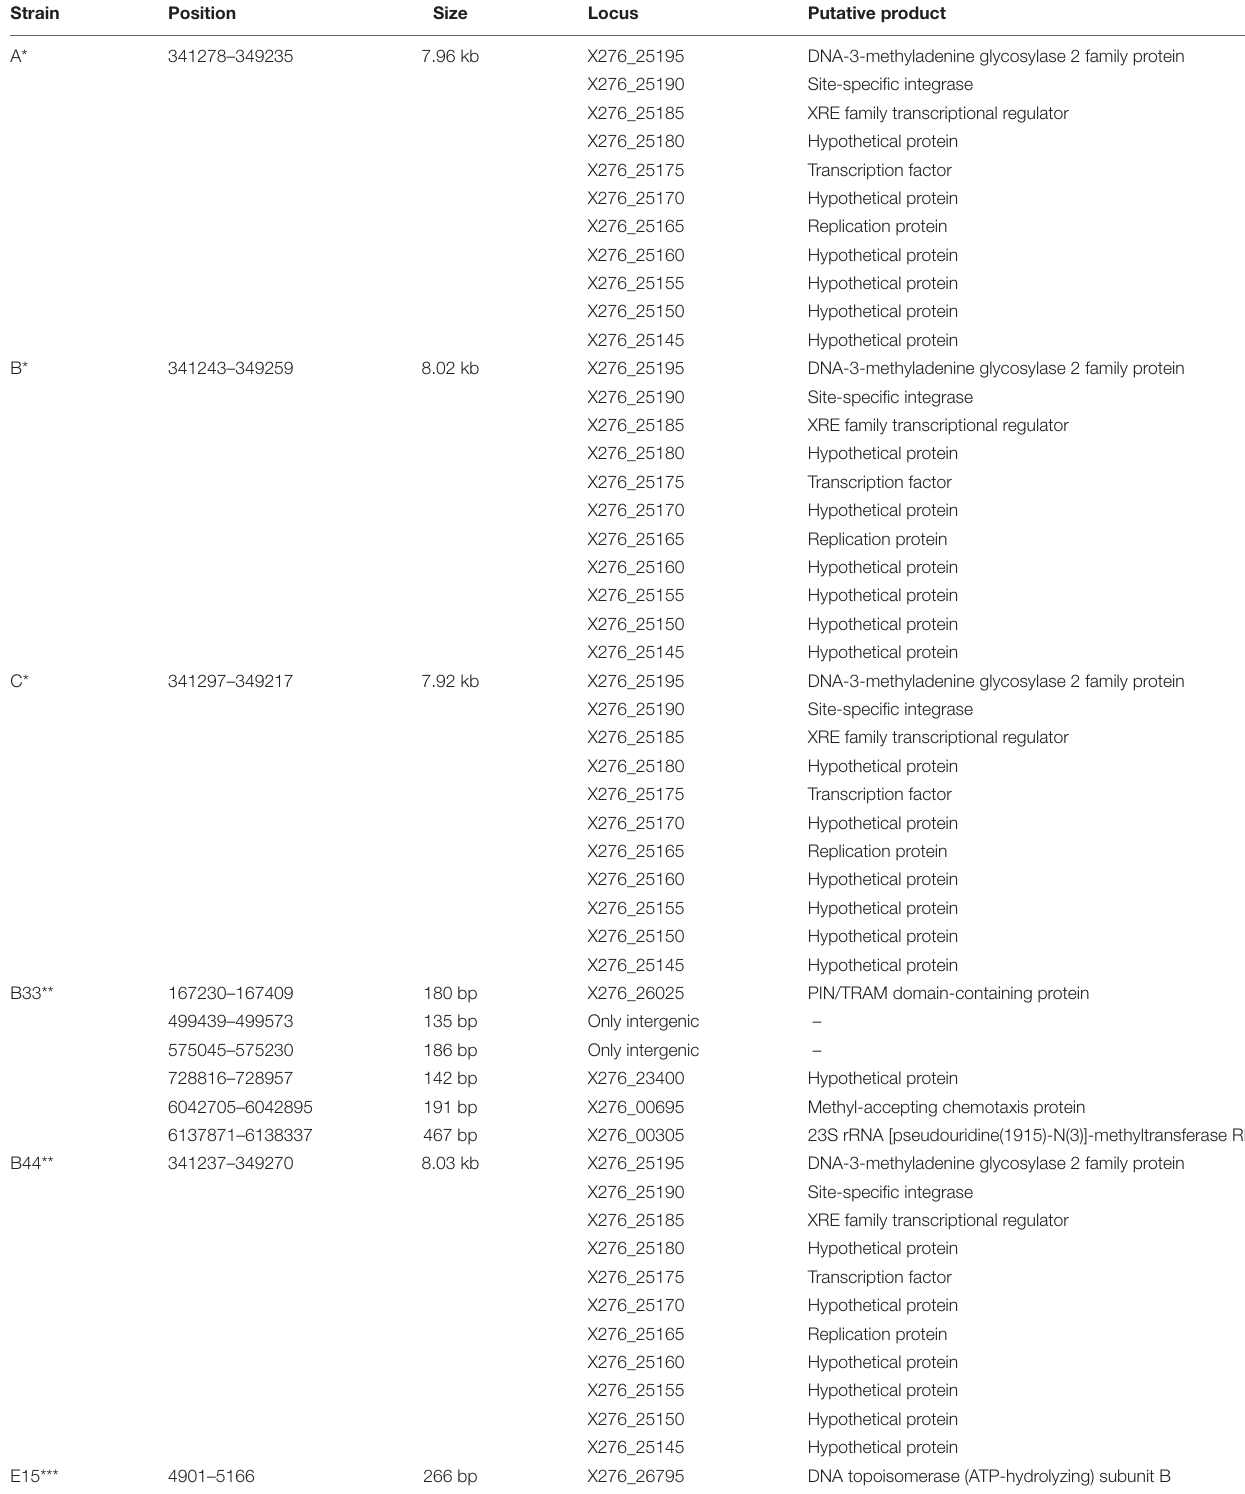
TABLE 5 | List of copy number variations in the genomes of mutant strains of C. beijerinckii NRRL B-598 exhibiting high butanol tolerance 1 . Strain Position Size Locus Putative